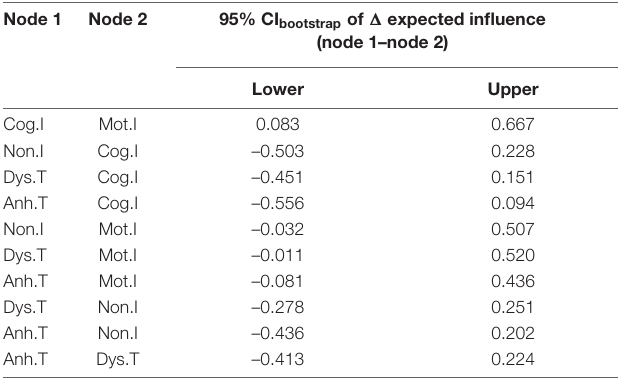
TABLE 3 | Expected influence comparisons of each